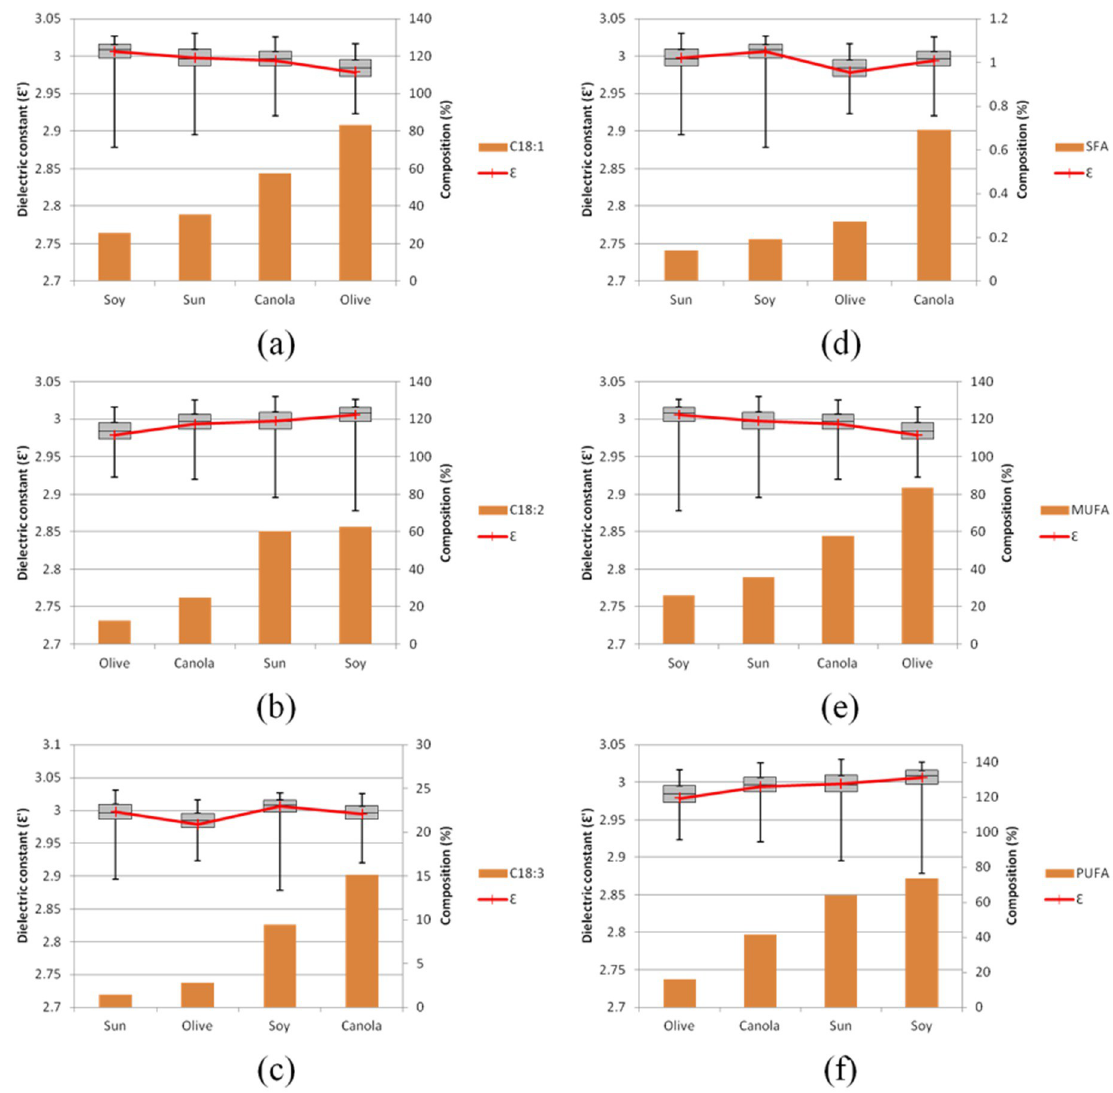
Fig 4. Correlation of (a) C18:1, (b) C18:2, (c) C18:3, (d) SFA, (e) MUFA and (f) PUFA composition with ε ’. constant was indicated as the two groups (C18:1-MUFA and C18:2-PUFA) were at two extreme ends of PC-2. As shown in Fig 5, the PCA loading plot, C18:3, and SFA correlate less to ε ’. The findings from the correlation loadings agree with the results from Fig 4. To predict the fatty acids profile (C18:1, C18:2, C18:3, SFA, MUFA, and PUFA) in vegetable oils, calibration models were developed using PCR and PLS regression algorithms with the pre- processed dielectric spectral data. The dependent variables, Y, were fatty acid components (C18:1, C18:2, C18:3, SFA, MUFA, and PUFA) of the vegetable oils, while the independent vari- ables, X, were ε ’ of oils measured over 166 frequencies. The optimal number of latent variables and principal components for the PLS and PCR regression model for all fatty acid models was determined to be five, where the cumulative explained variance is high, and the RMSECV is at the minimum as suggested in a previous study [59]. PCR and PLS regression showed substantial cross-validation performance as measured by RMSECV for all fatty acids, as shown in Table 5.